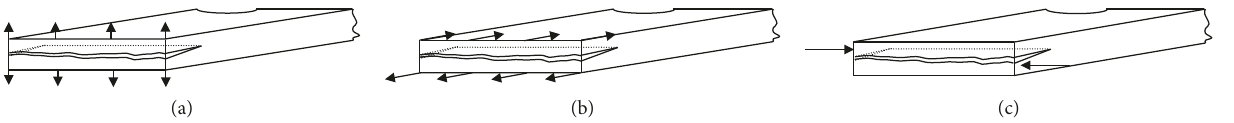
Figure 10: Three fracture modes: (a) opening fracture mode (mode I crack), (b) sliding fracture mode (mode II crack), and (c) tearing fracture mode (mode III